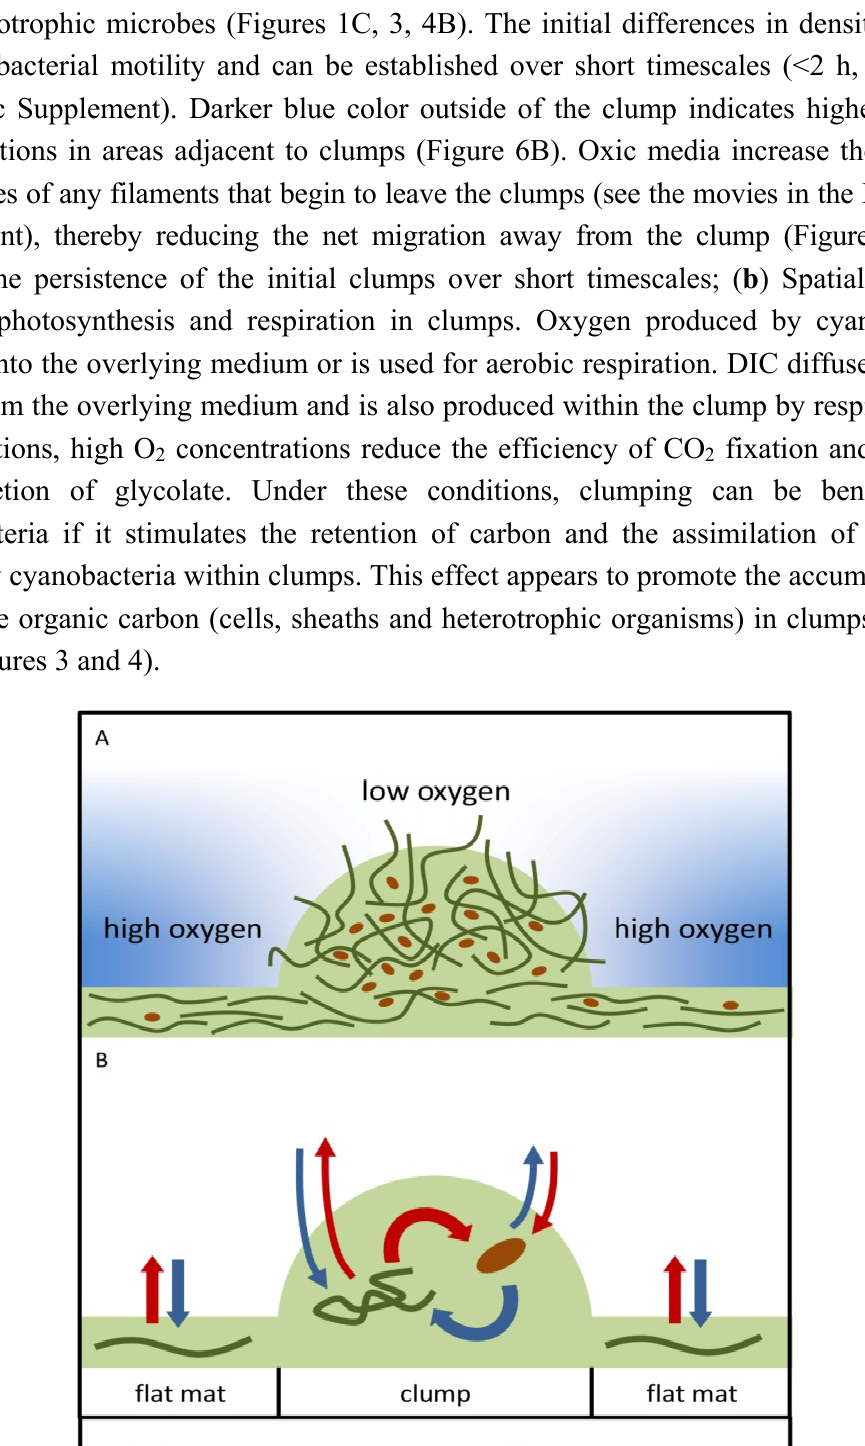
Figure 7. Proposed model of microbial distribution, spatial organization, carbon and O cycling in clumps and adjacent areas. ( a ) Clumps contain denser cyanobacterial filaments and heterotrophic microbes (Figures 1C, 3, 4B). The initial differences in density depend on cyanobacterial motility and can be established over short timescales (<2 h, Figure 5, Electronic Supplement). Darker blue color outside of the clump indicates higher